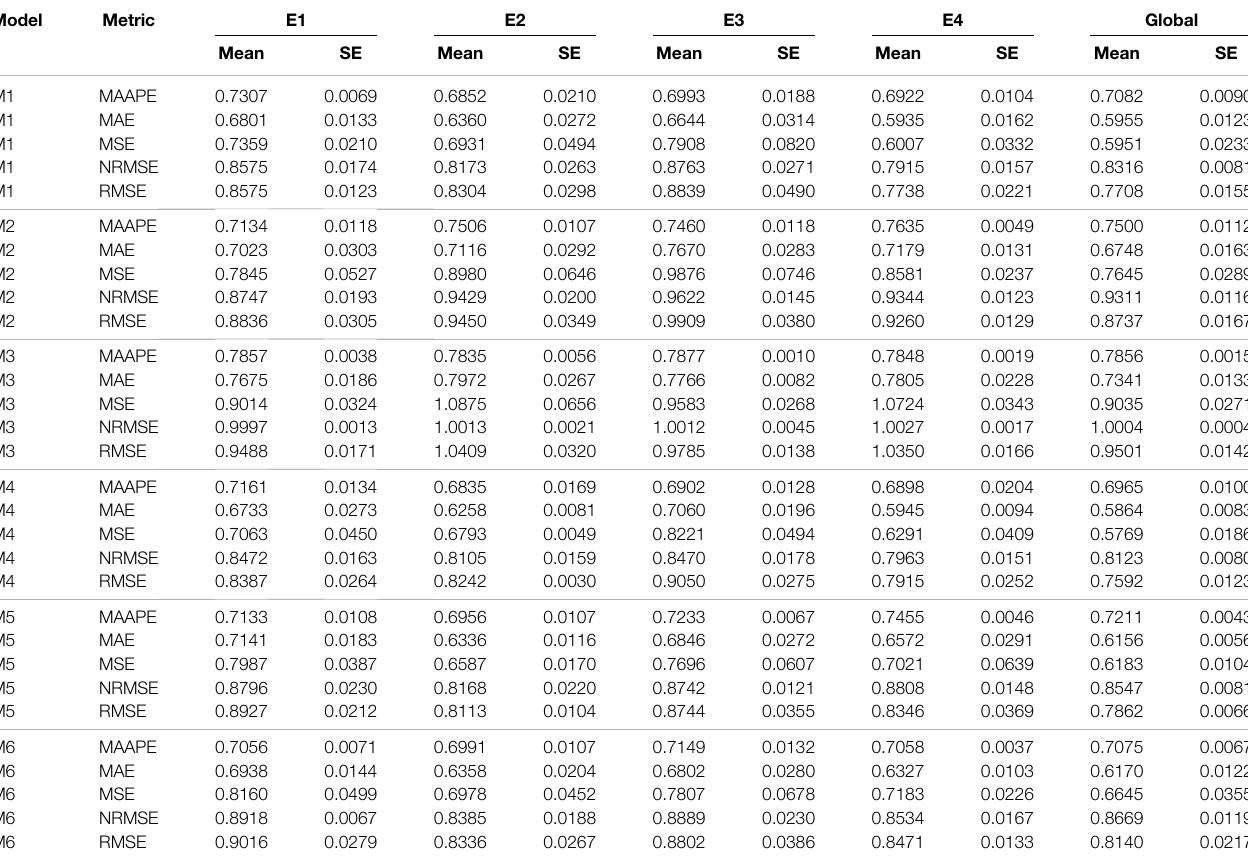
TABLE 2 | Prediction performance of the Wheat data set for each environment and across environments (Global) of each of the six models.